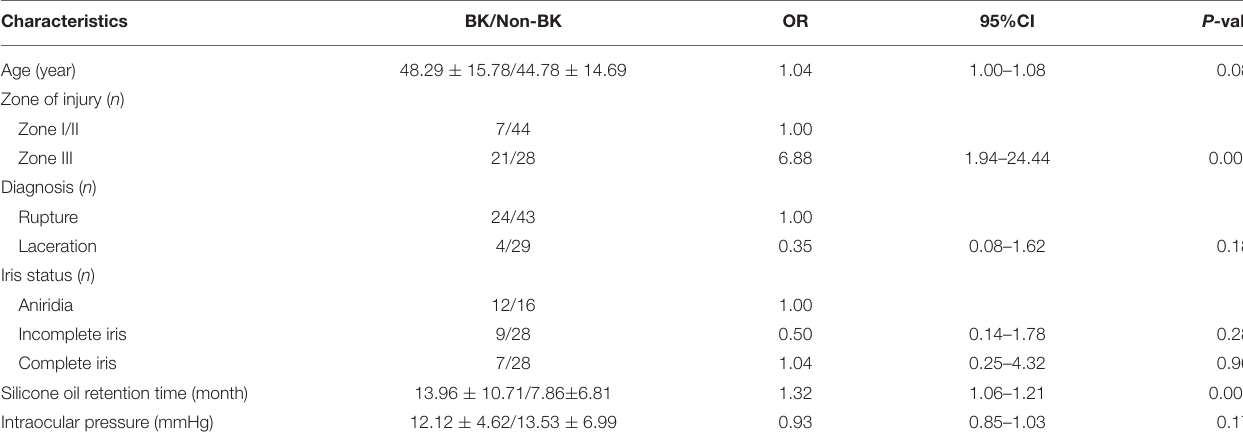
TABLE 2 | Odds ratios for the association between risk factors and band keratopathy.